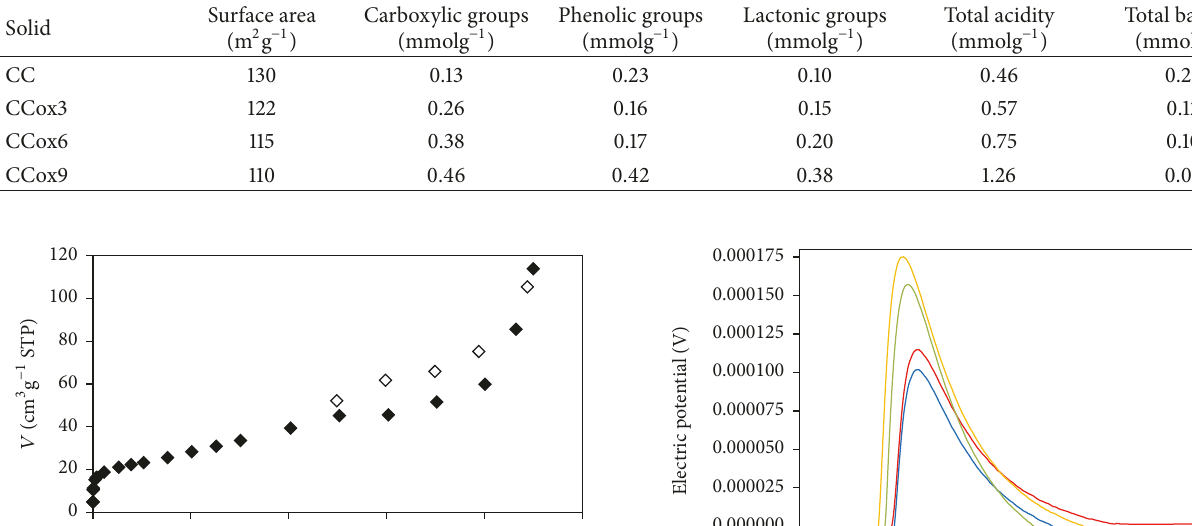
Table 1: Physiochemical characterization of the carbonized oxidized solids.